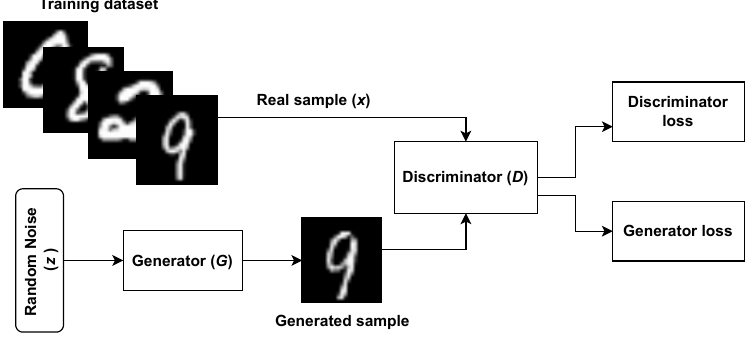
Figure 1. Architecture of the original GAN